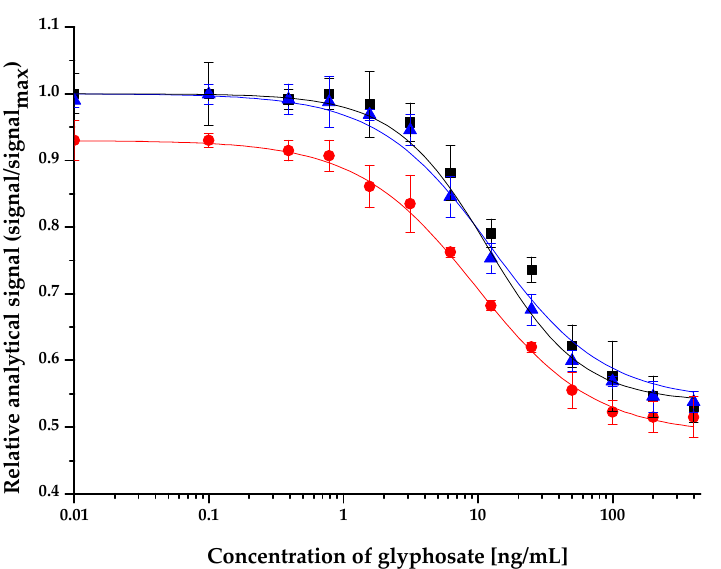
Figure 2. Calibration curve of the competitive enzyme-linked fluorescent immunoassay obtained in assay buffer (black), Danube surface water sample (blue), and soil diluted by 1:10 rate (red) matrices at concentration range of 0– 400 ng/mL glyphosate. Table 5. Matrix effect in surface water and in soil extract determined by a comparison of IC 50 values obtained in the matrices and the calibration curve in assay buffer.